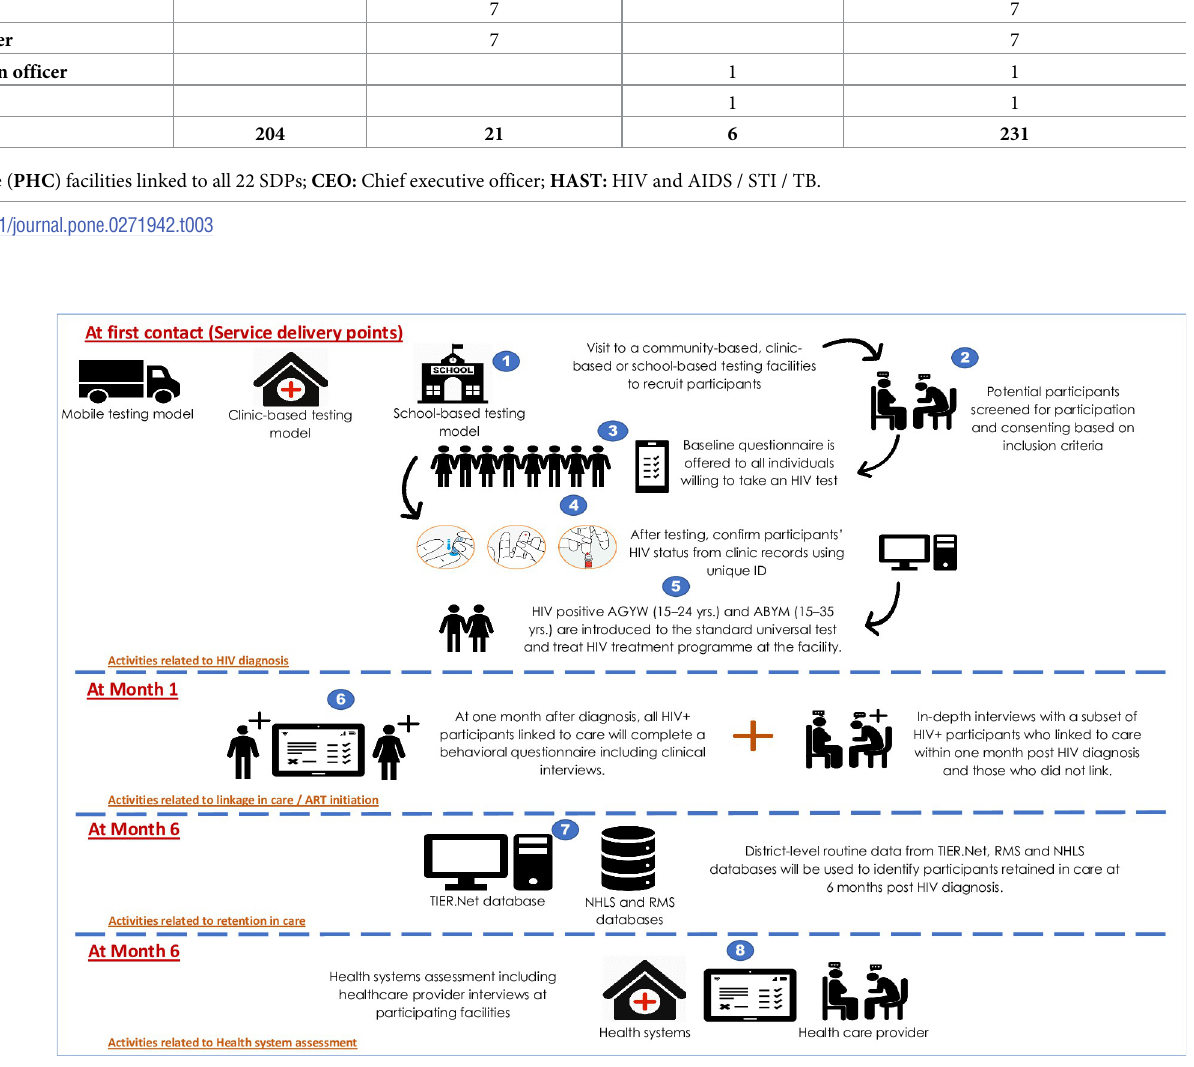
PLOS ONE | https://doi.org/10.1371/journal.pone.0271942 February 13,